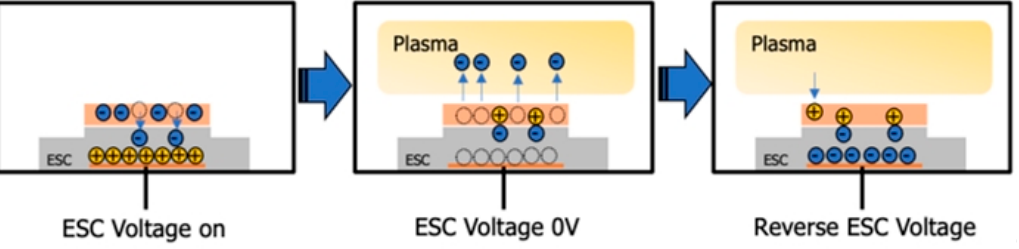
Figure 17. Neutralization process in the wafer de-chucking step.